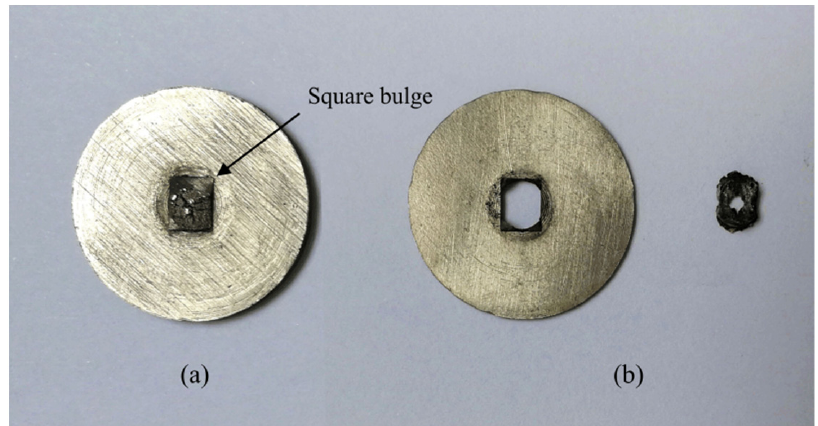
Figure 35. Residual body. ( a ) 650 μ m ; ( b ) 300 μm .